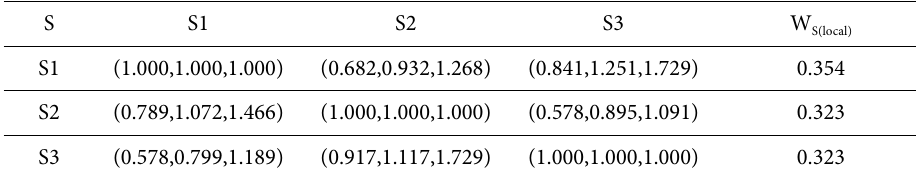
Table 8. Pair-wise comparison matrices and local weights for “S”-factor